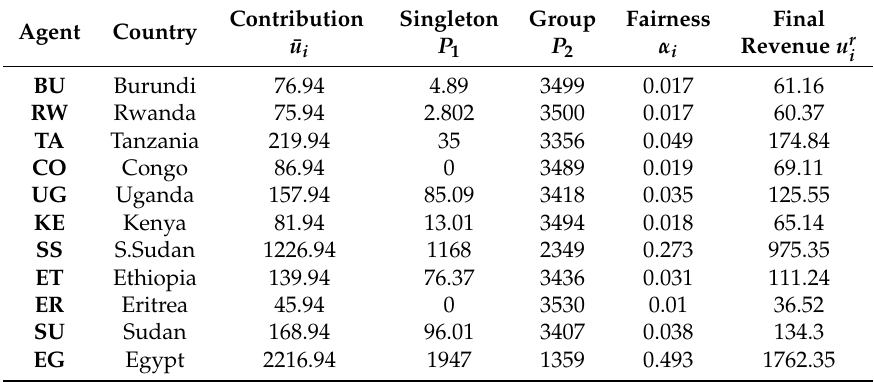
Table 5. Water resource allocation